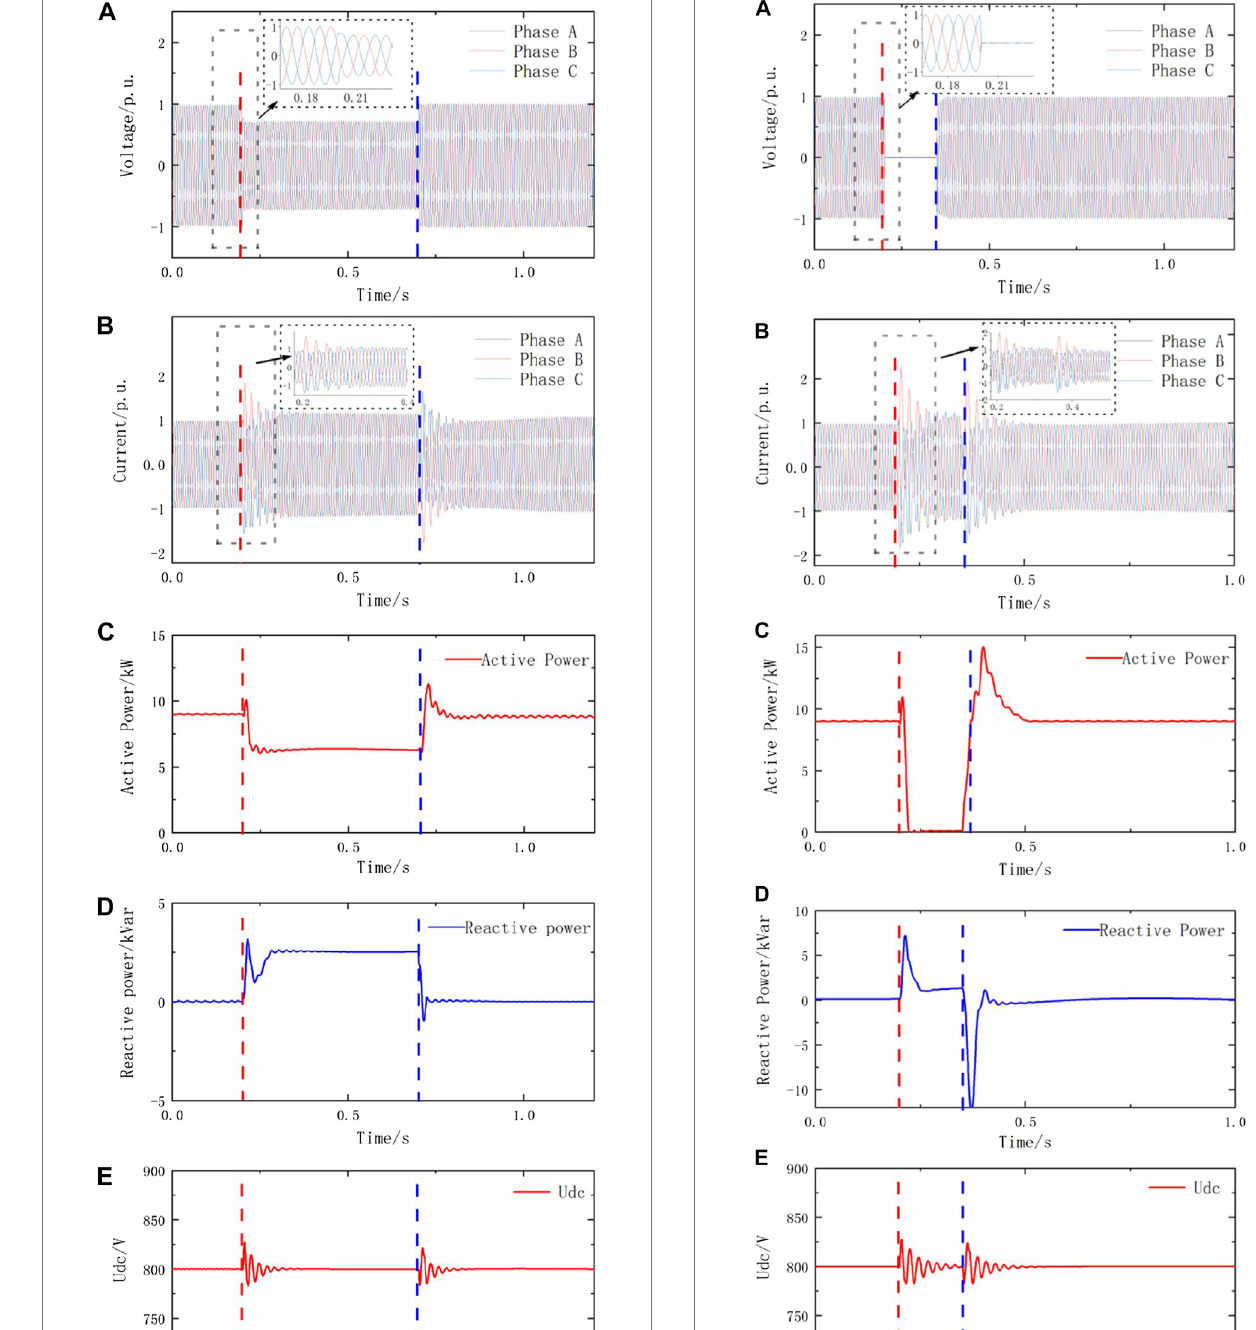
Figure 5 simulates the situation when a zero voltage drop fault occurs in the power grid. At t = 0.2s, the grid voltage dips to 0, and continues until the fault ends at t = 0.35s. Observing Figure 5A , it